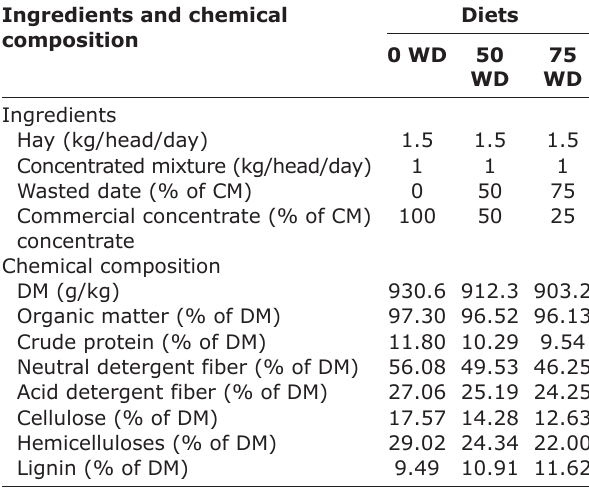
Table 1: Ingredients and chemical composition of experimental diets. Ingredients and chemical